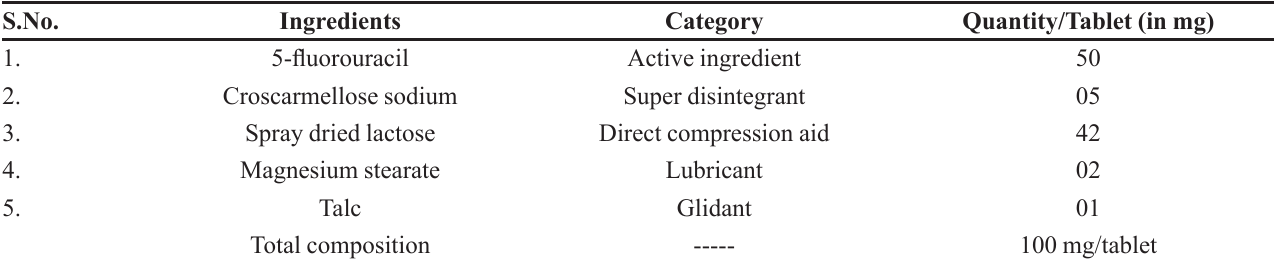
TABLE I - Composition of fast disintegrating and dissoluting 5-fluorouracil core tablet